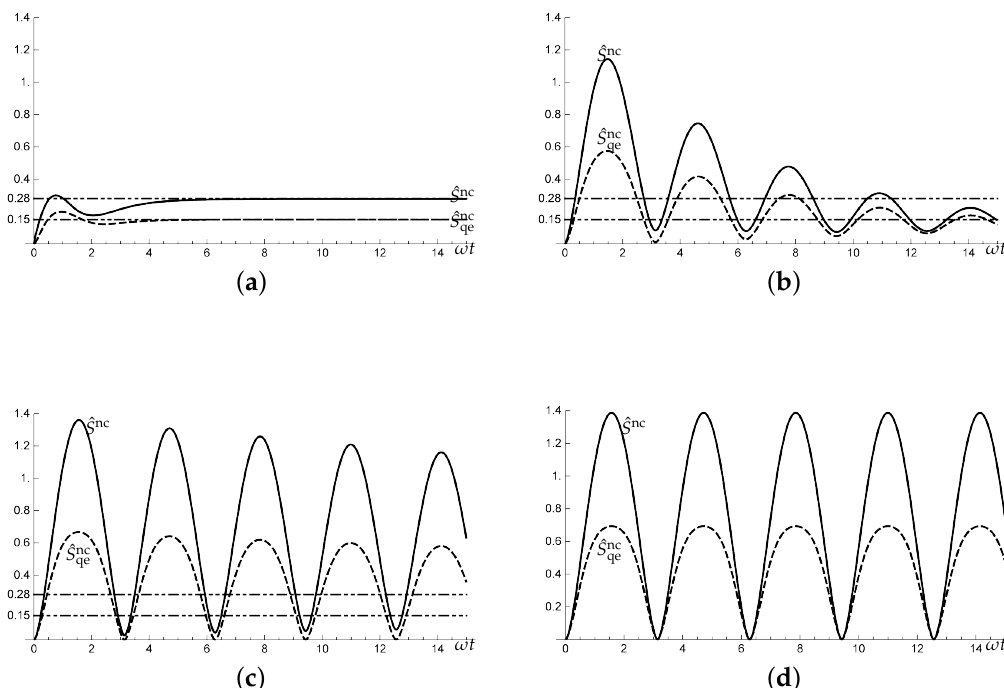
Figure 3. Time dependence of ˆ S nc ( ----- ) and ˆ S nc qe ( --- ) in dissipative and non-dissipative systems with K − 1 = ( β J ) − 1 = 0.7 and h = β g µ B H = 3/7 for the non-competing cases. Parts ( a – c ) show cases with scaled dissipation rates of e / ω = 1, 0.1, and 0.01, respectively. The dot-dot-dashed lines ( - - ) in parts ·· ( a – c ) represent the asymptotes of the ˆ S nc and ˆ S nc qe curves. In part ( d ), which is the non-dissipation case ( e = 0), all the curves have the same phase. In these and all subsequent plots, k B = 1.